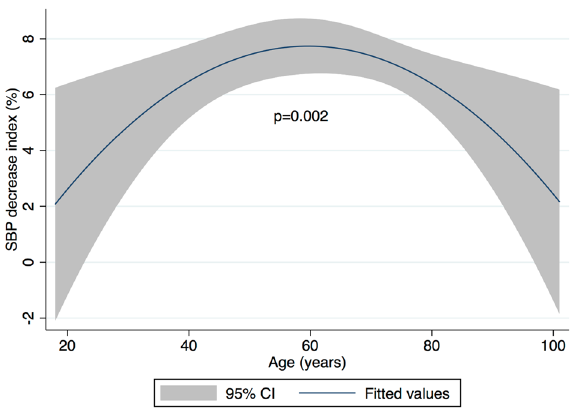
Figure 2. Multivariate relationship between SBP decrease index (%) and age (years). Relationship is based on the final multivariate model and is thus adjusted for: BMI, antihypertensive medication, serum albumin, dialysis vintage, dialysate calcium, UFR and Kt/V. Blue line represent fitted values and grey area represent 95% confidence interval. SBP systolic blood pressure, BMI body mass index, UFR ultrafiltration